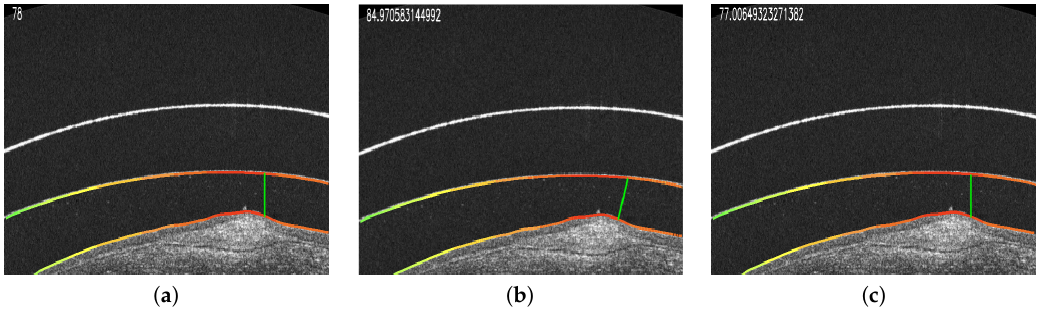
Figure 12. Examples of application of the nearest point paradigm for the calculation of the distance between the cornea and the SCL. ( a , b ) Solution of the nearest point paradigm to the limitations of the normal direction one in Figure 11c,d. ( c , d ) Additional illustrative examples of the nearest point paradigm, where the cornea–contact lens (CL) relationship is measured accurately.